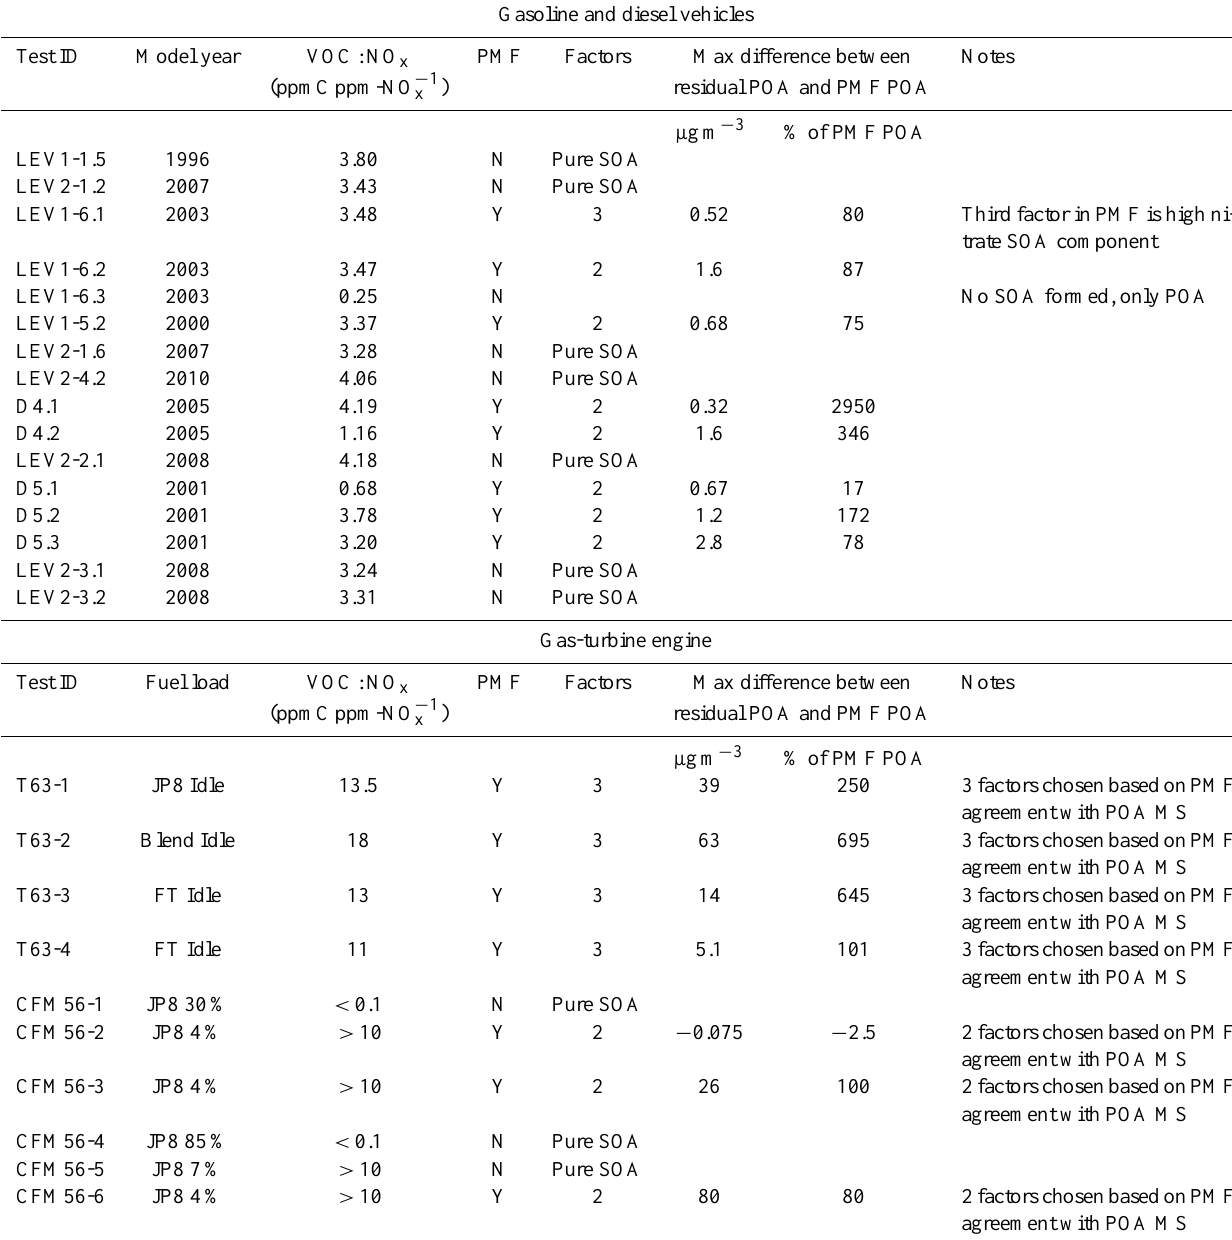
Table 1. List of smog chamber experiments. Vehicles are identified by their model year and a unique identifier that indicates either the control level (LEV1 or LEV2) for gasoline vehicles or fuel (D) for diesel vehicles, a number assigned to the vehicle as part of the larger fleet presented in May et al. (2014), and the experiment number with that particular vehicle. Gas-turbine engine experiments are grouped based on the engine (CFM56 or